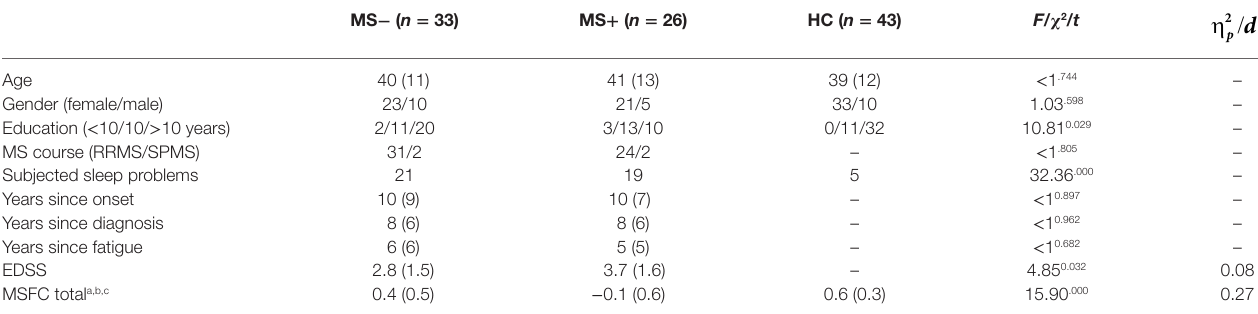
TaBle 1 | Sample characteristics of MS patients (MS − ) without and with comorbid (MS + ) disorders in comparison to healthy controls